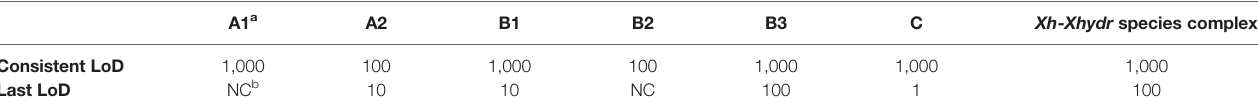
TABLE 5 | Summary of the consistent and last limits of detection (LoD) of cell-based assays, reported in number of bacteria in 1 µl of LAMP reaction. A1 a